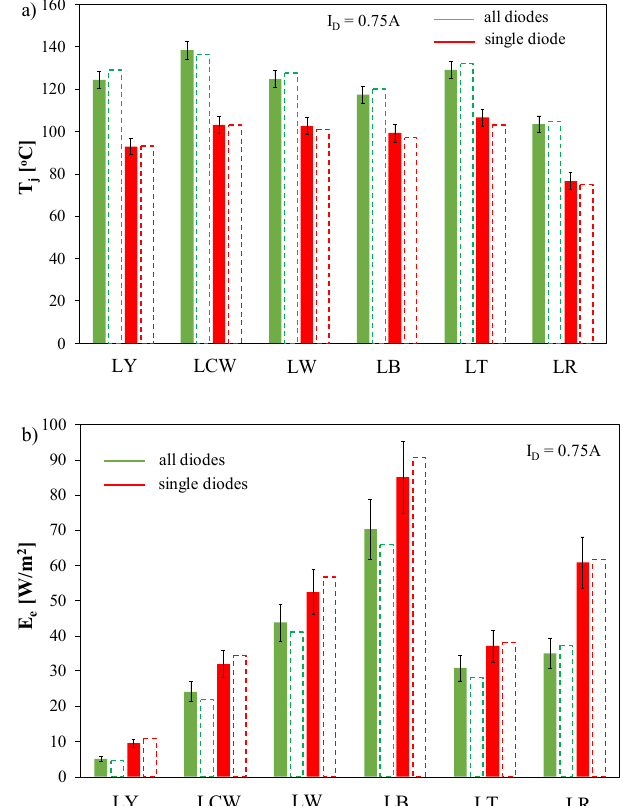
Figure 11. Computed (empty bars) and measured (full bars) values of junction temperature ( a ) and the surface power density of the emitted light ( b ) for the power LEDs operating alone and together with the other diodes situated on the common PCB.